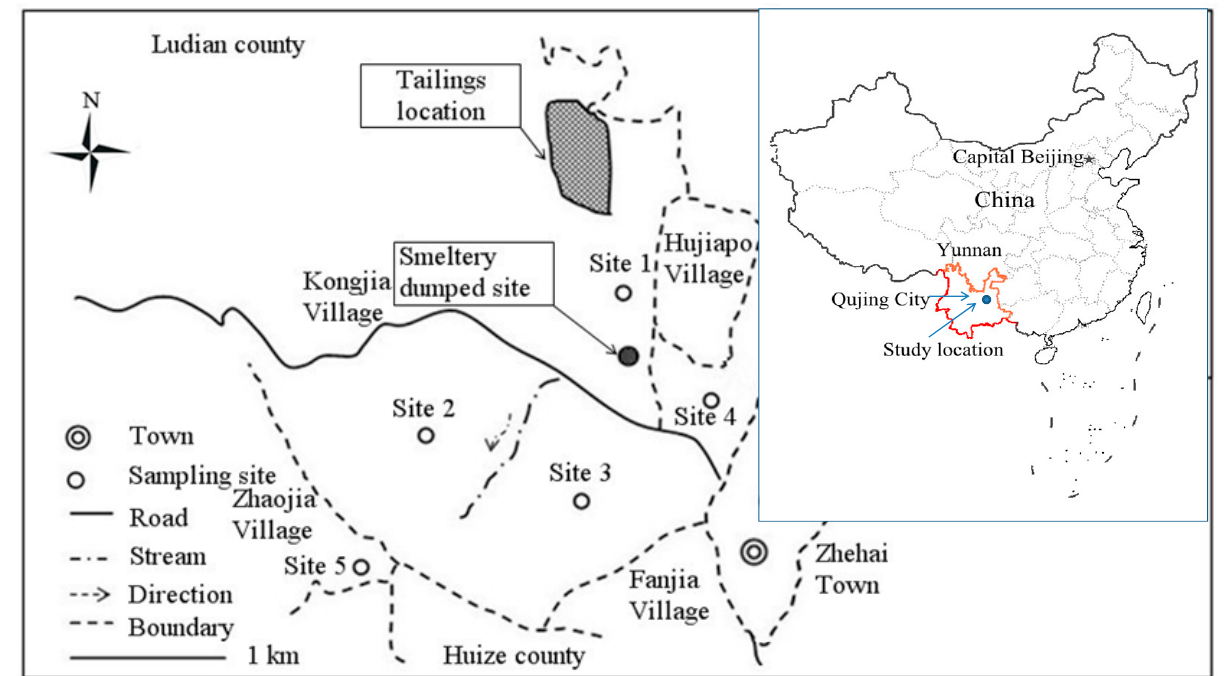
Figure 1. Sampling locations of the present study in Zhehai town, Qujing city in Yunnan Province, China.